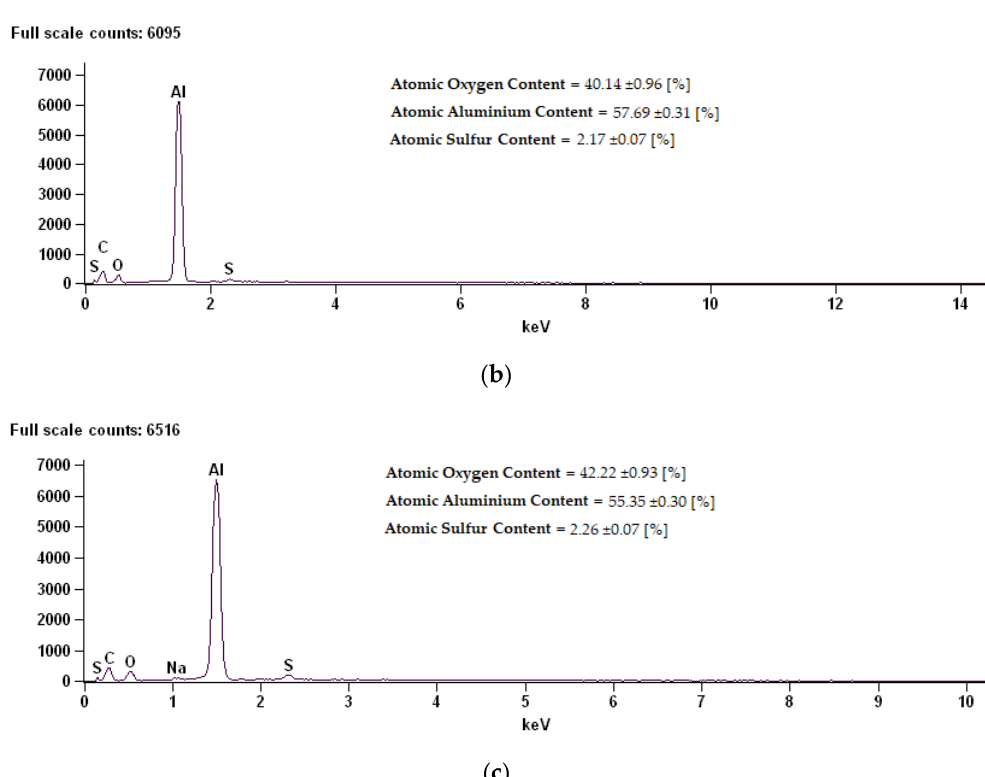
Figure 6. EDS (Energy Dispersive X-ray Spectroscopy) spectrum along with chemical analysis for samples: ( a ) Sample 02D, ( b ) Sample 02E, ( c ) Sample 02K.